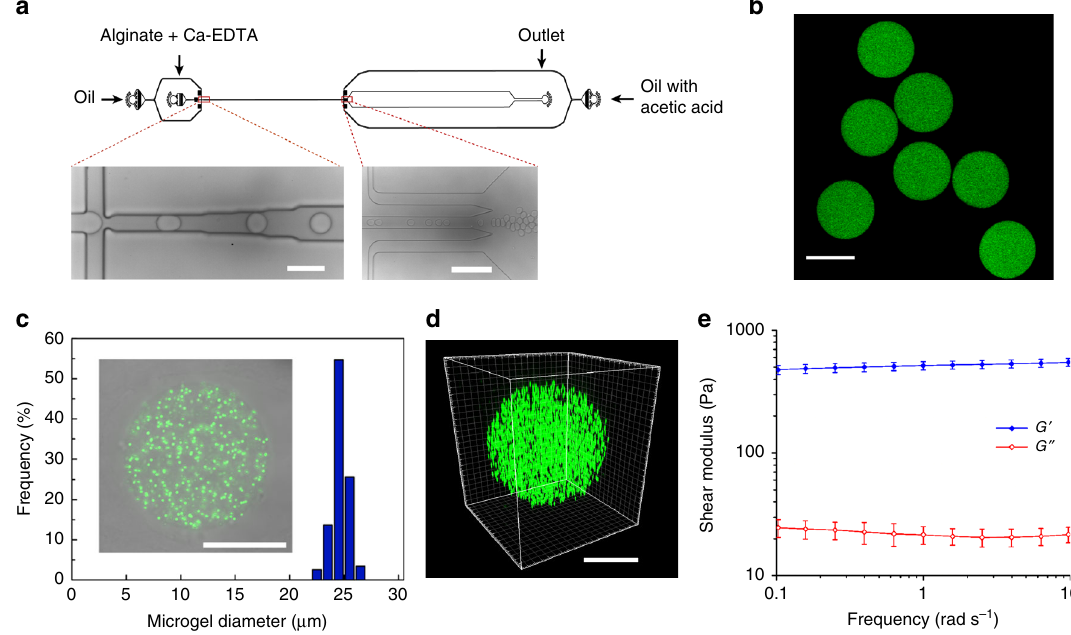
Fig. 1 Fabrication of alginate microgels. a Schematic and microscopic images of the micro fl uidic device for alginate droplet generation. Right and left scale bares are 200 and 50 µ m, respectively. b All alginate microgel droplets are uniform in size. Scale bar, 25 μ m. c Confocal section and size distribution of the homogenous, 200-nm fl uorescent nanoparticles-labeled elastic round microgel (ERMG). d 3D confocal image of an ERMG. Scale bars in c and d , 15 µ m. e Characterization of rheological properties of alginate hydrogels using shear rheology. Mean ± s.e.m.; n = 6 hydrogel